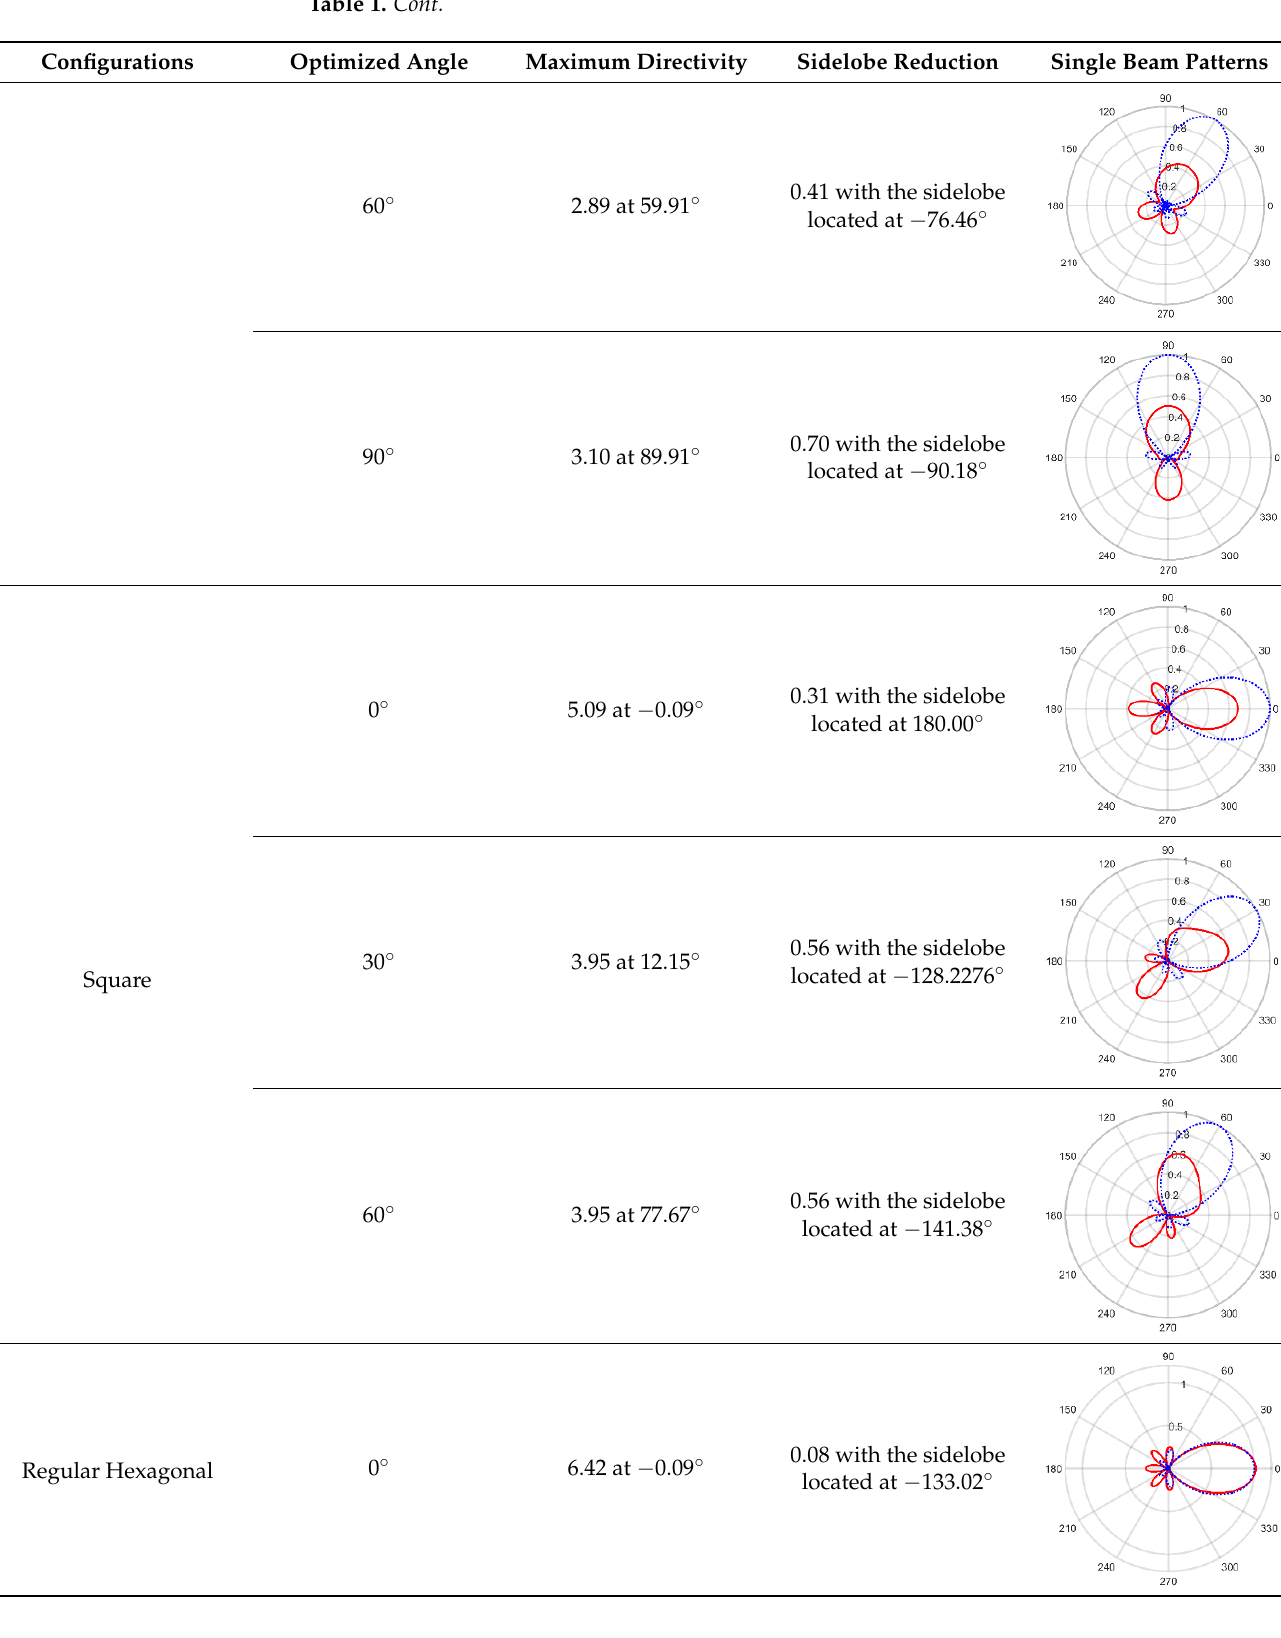
Table 2. Directivity, Sidelobe Reduction and Single Beam Patterns for the newly proposed Array Models, where the blue and read lines are showing the desired beam and optimized beam patterns, respectively. Configurations Optimized Angle